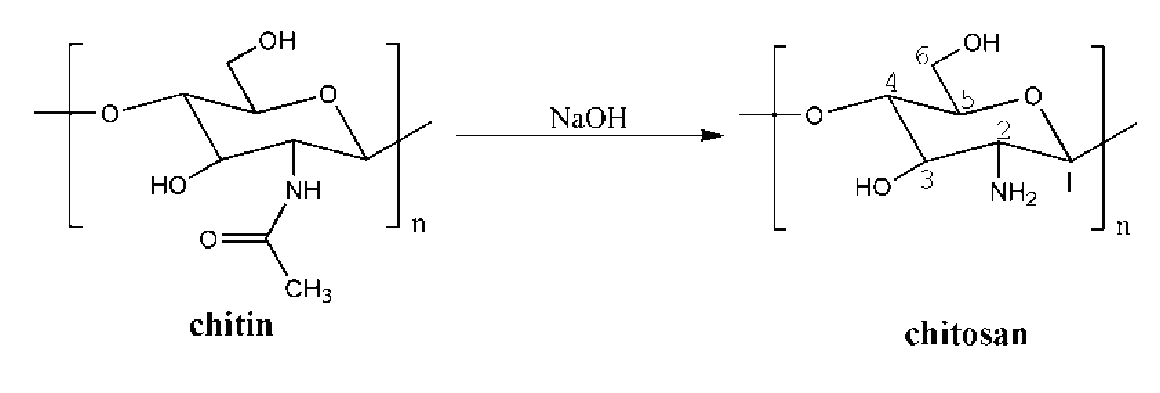
Figure 1. Schematic of molecular imprinting.